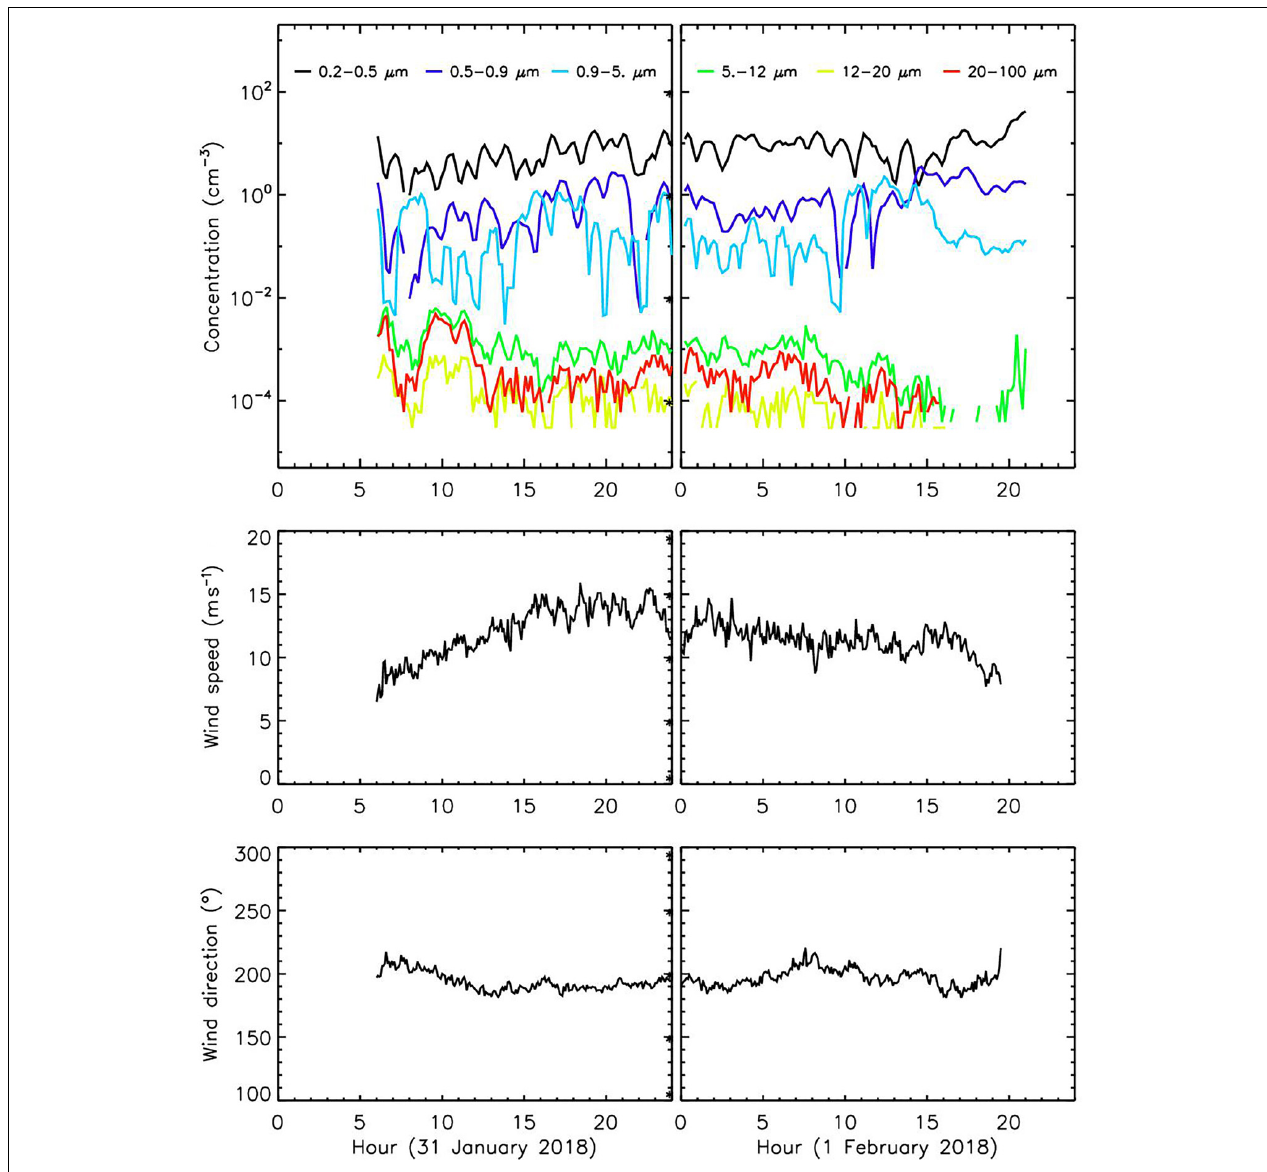
FIGURE 9 | Event 1 – wind conditions and aerosol